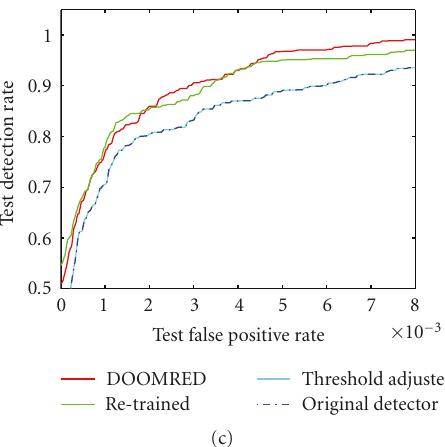
Figure 4: The ROC curves of the single layer detectors when the number of (a) 10 (b) 20 (c) 40 false rejected target instances are